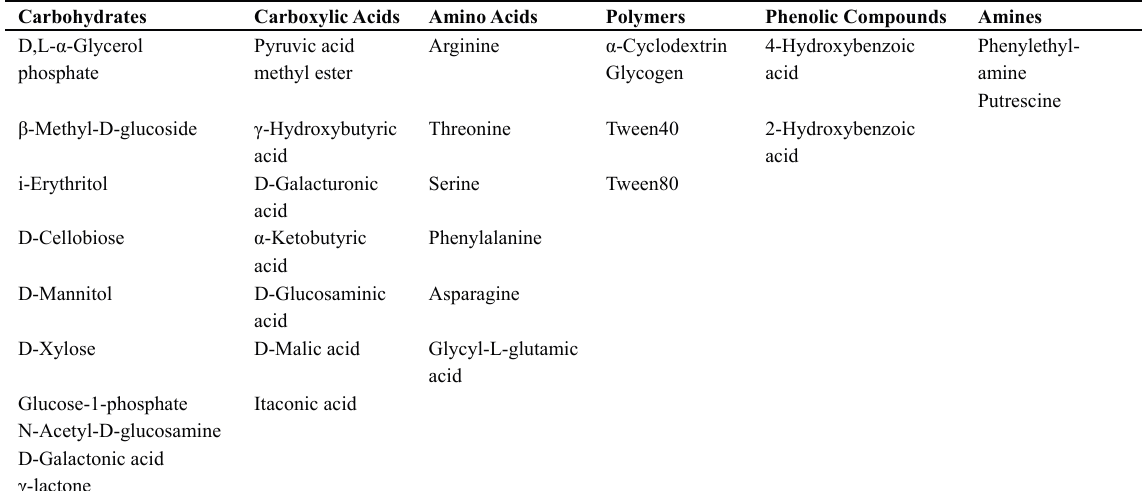
Table 1. Sole carbon sources used in the BIOLOG ECO microplate used in this work [4,21,22]. Carbohydrates Carboxylic Acids Amino Acids Polymers Phenolic Compounds